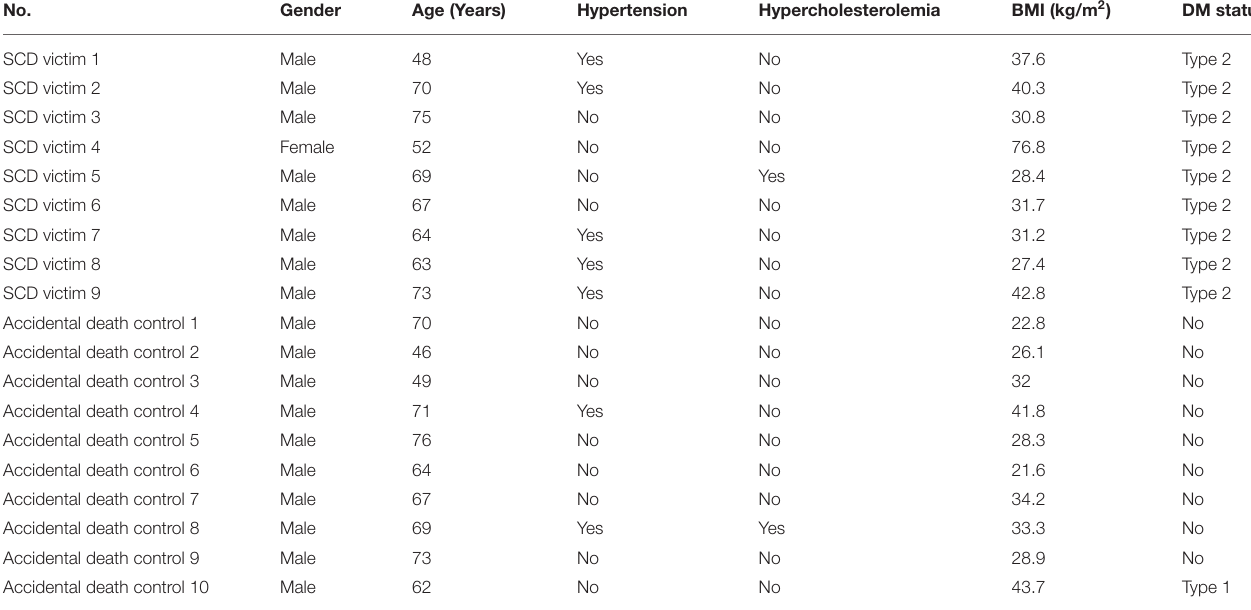
TABLE 1 | Study population information. No.